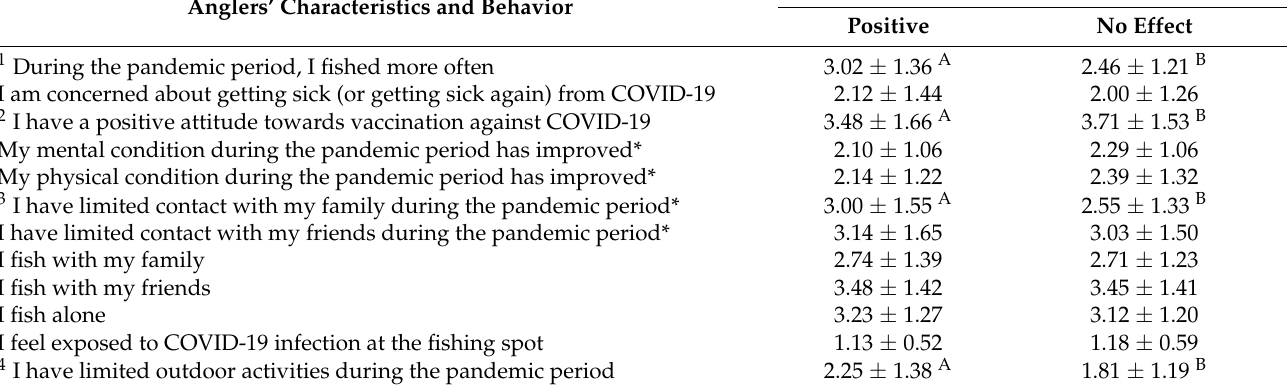
Table 3. Differences between anglers’ groups with different stress reduction perceptions: with a noticeable reduction of pandemic stress through angling (Likert score answers 4–5; N = 360; MoE = 5.0%) and without it (Likert score answers 1–2; N = 93; MoE = 7.5%). Results are presented using the mean score ±